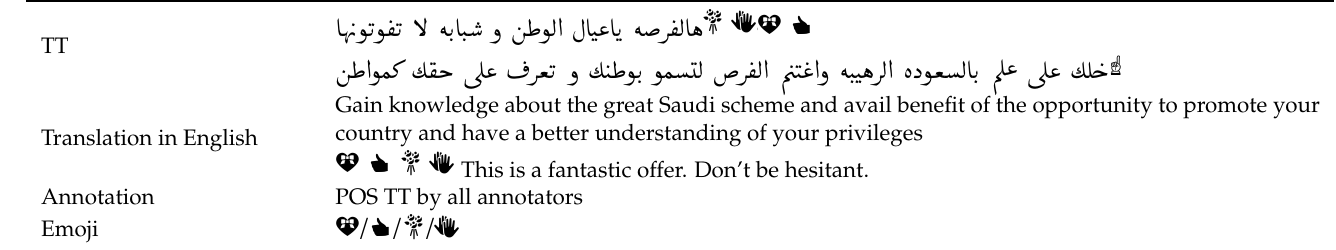
Table 8. TT sample comprising emoji.